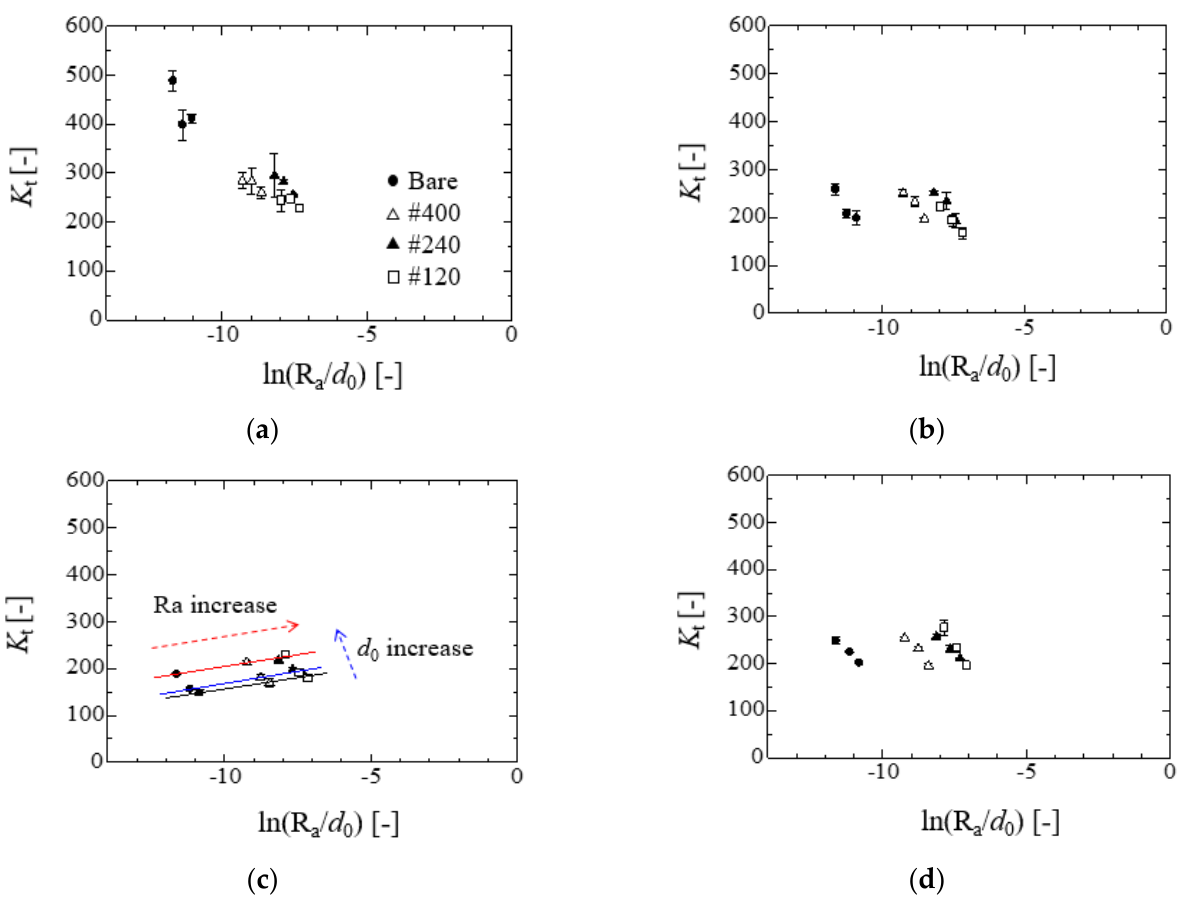
Figure 9. Relationship between K t and ln(Ra/d0): ( a ) 5 wt%; ( b ) 20 wt%; ( c ) 70 wt%; and ( d ) 99.4 wt%. The error indicates two standard deviation (2SD).